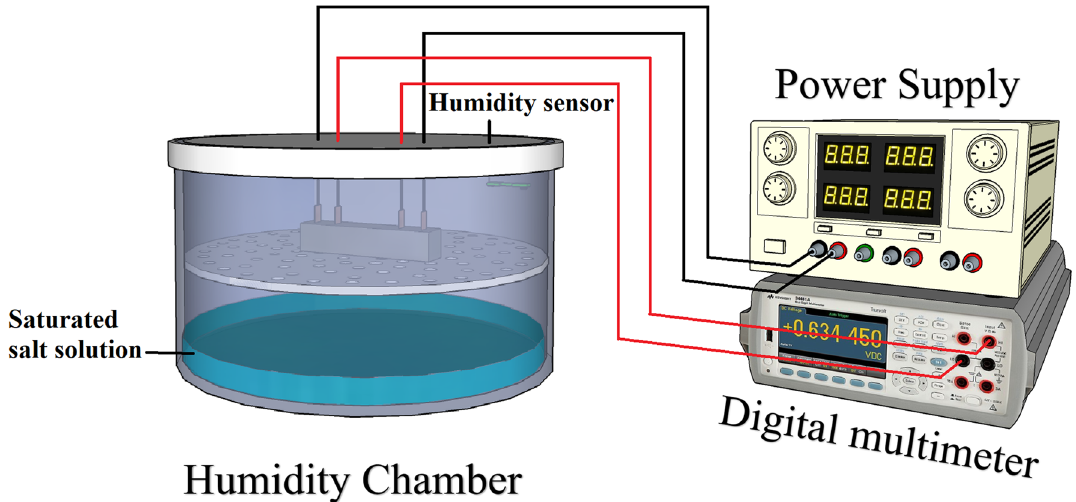
Figure 3. The experimental setup for electrical resistance measurements of mortar samples. This figure was created using Sketchup version 2017 (https:// www. sketc hup. com), Microsoft PowerPoint version Microsoft 365 (https:// www. micro soft. com/ en- us/ micro soft- 365/ power point).